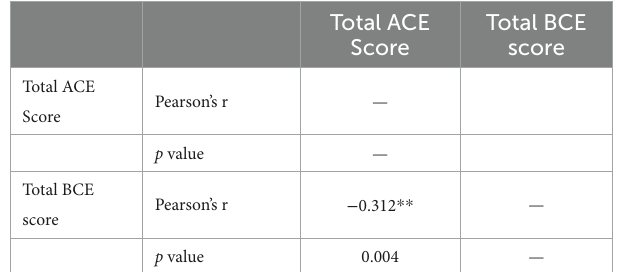
TABLE 6 Correlation matrix between ACEs and BCEs.